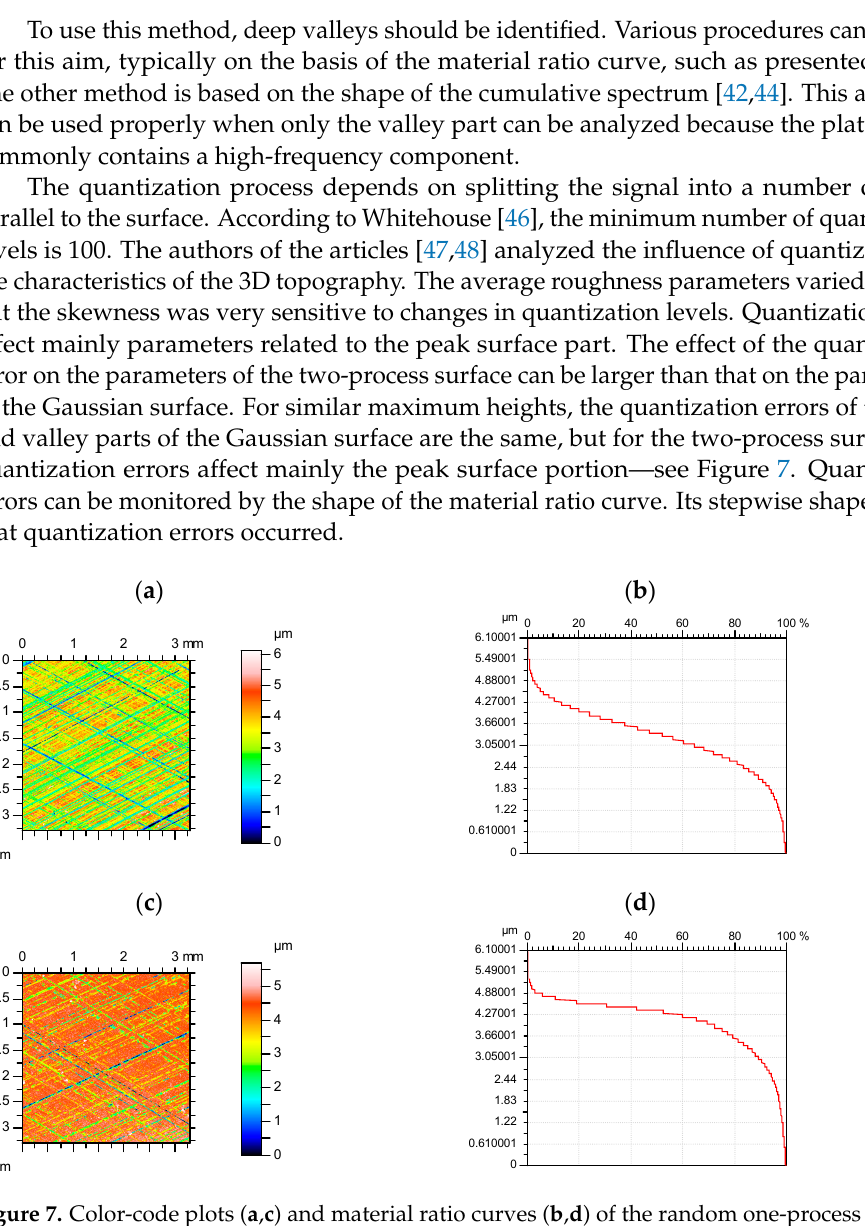
Figure 6. The effect of the sampling interval on the depth of the deep valley, after [45].